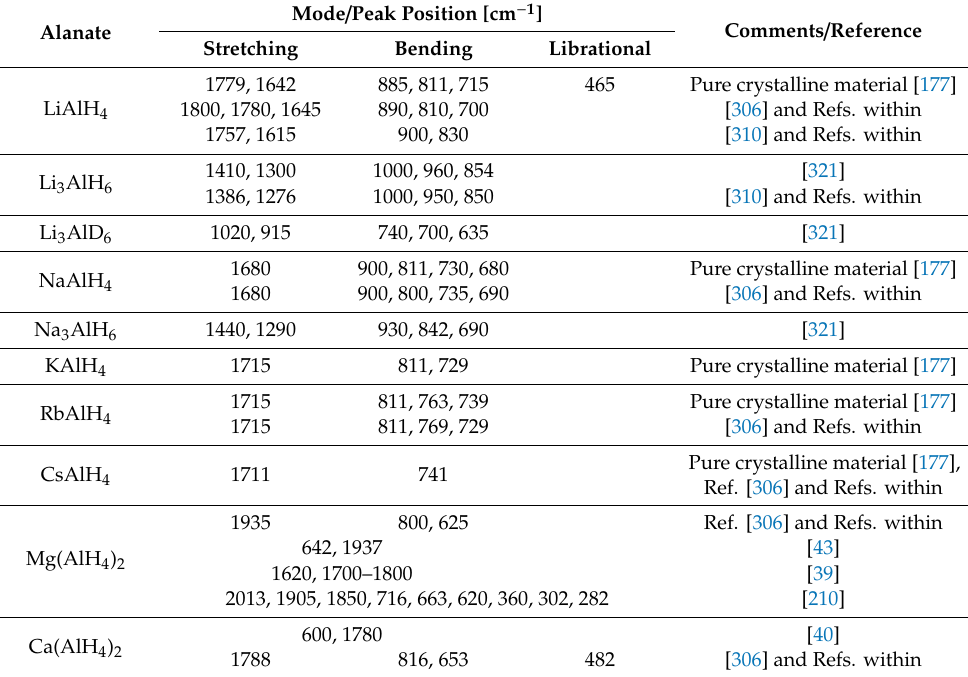
Table 19. Representative infrared frequencies of Al-H bonds reported for di ff erent